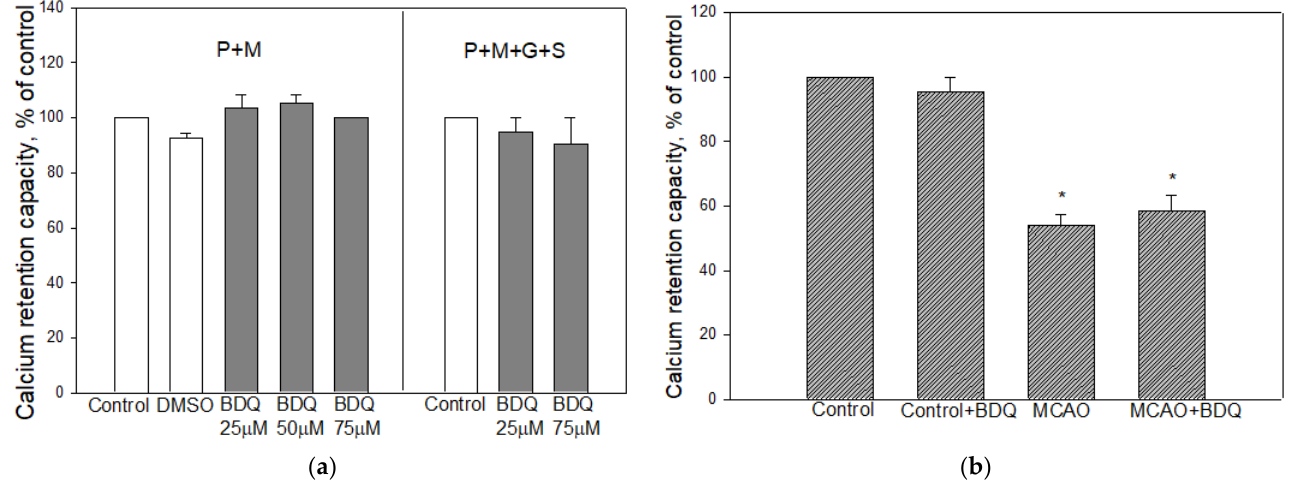
Figure 4. Effect of BDQ on mitochondrial calcium retention capacity. ( a )—the direct effect of BDQ and vehicle dimethyl sulfoxide (DMSO) on isolated brain mitochondrial calcium retention capacity using pyruvate and malate or pyruvate, malate, glutamate, and succinate as substrates; ( b )—mitochondrial calcium retention capacity after MCAO with/without BDQ using pyruvate and malate as substrates. Data are presented as Mean ± SEM of 3–6 experiments on individual animals. *—Statistically significant difference compared to control ( p <